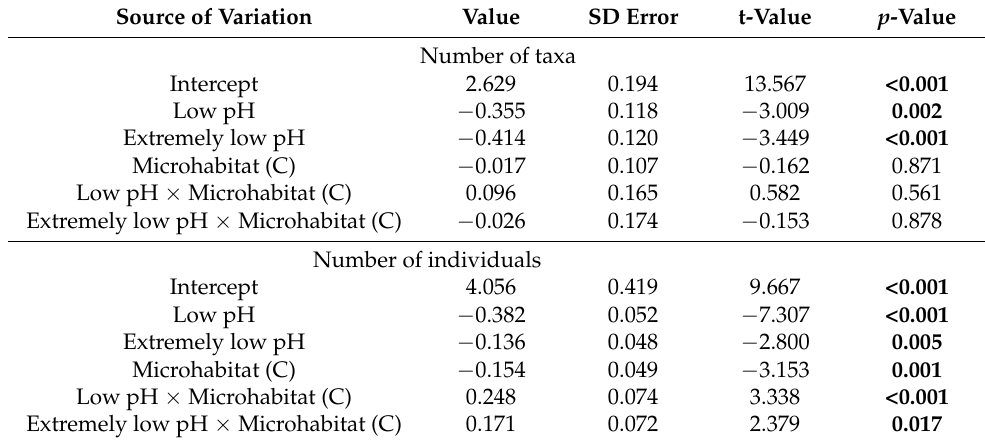
Figure 2. Mean number of individuals (cyan) and mean number of taxa (dark blue) with SD bars according to site (N, S, and Vu), pH stations, and microhabitats within the meadow (C = canopy; B = bottom). Number of individuals’ axis break for the South (S) site is indicated in red. Table 3. Outputs of the GLMMs carried out on the number of taxa and number of individuals. Significant values are highlighted in bold.